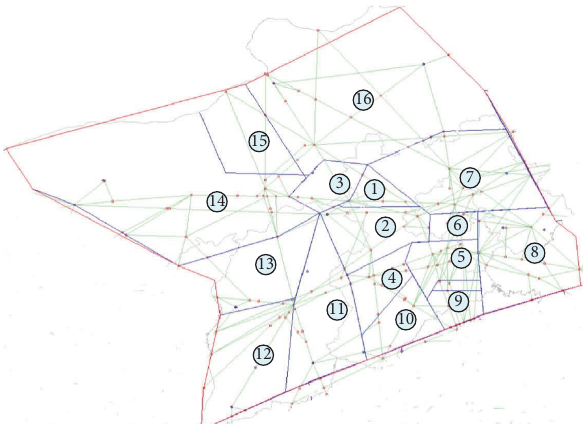
Figure 8: Te diagram of BCA.